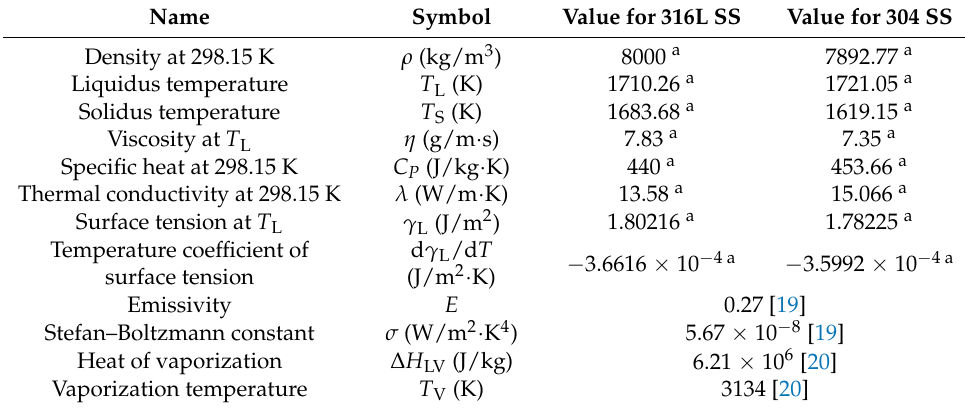
Table 2. Parameters used in CtFD